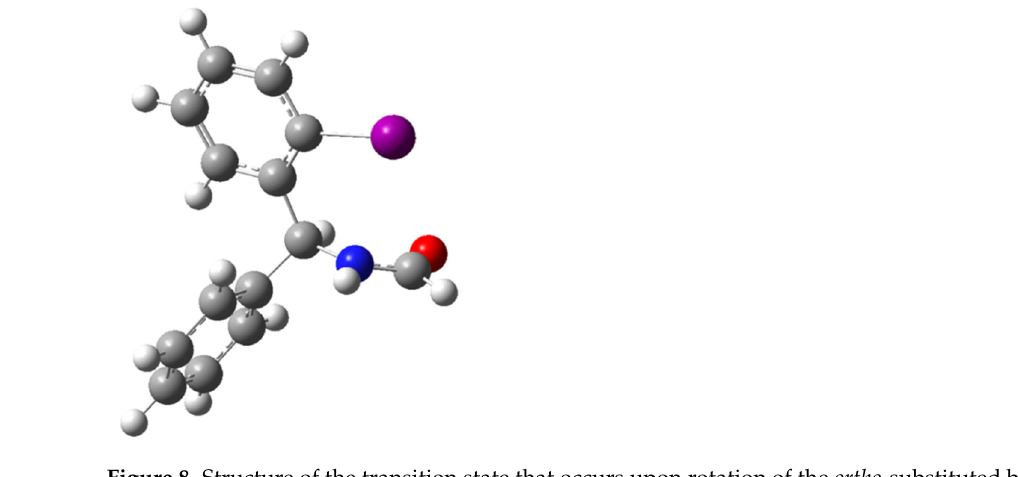
Figure 8. Structure of the transition state that occurs upon rotation of the ortho -substituted benzene ring in molecule BHFA-oI.